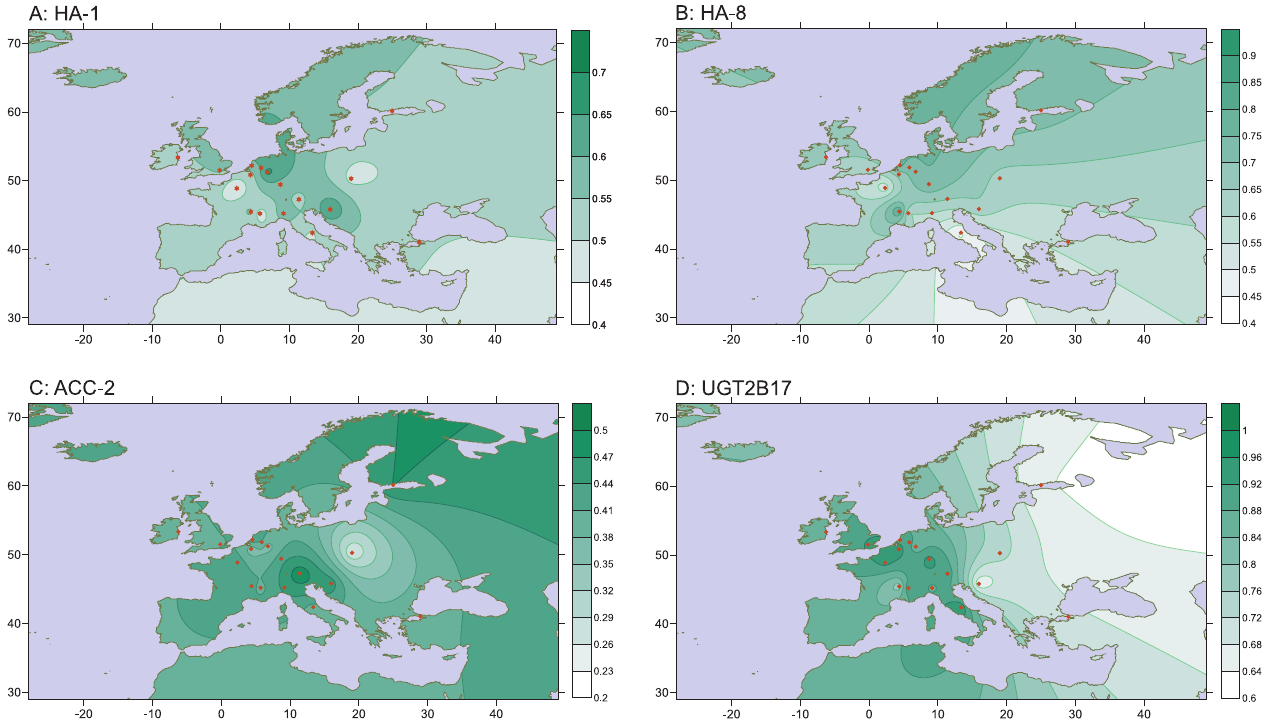
Figure 1. Geospatial Analyses of the Phenotype Frequencies of HA-1 (A), HA-8 (B), ACC-2 (C), and UGT2B17 (D) in the European White Populations Red dots represent the centers from which the frequency data were obtained. Numbers in the scaling indicate the proportion of individuals with an immunogenic phenotype.